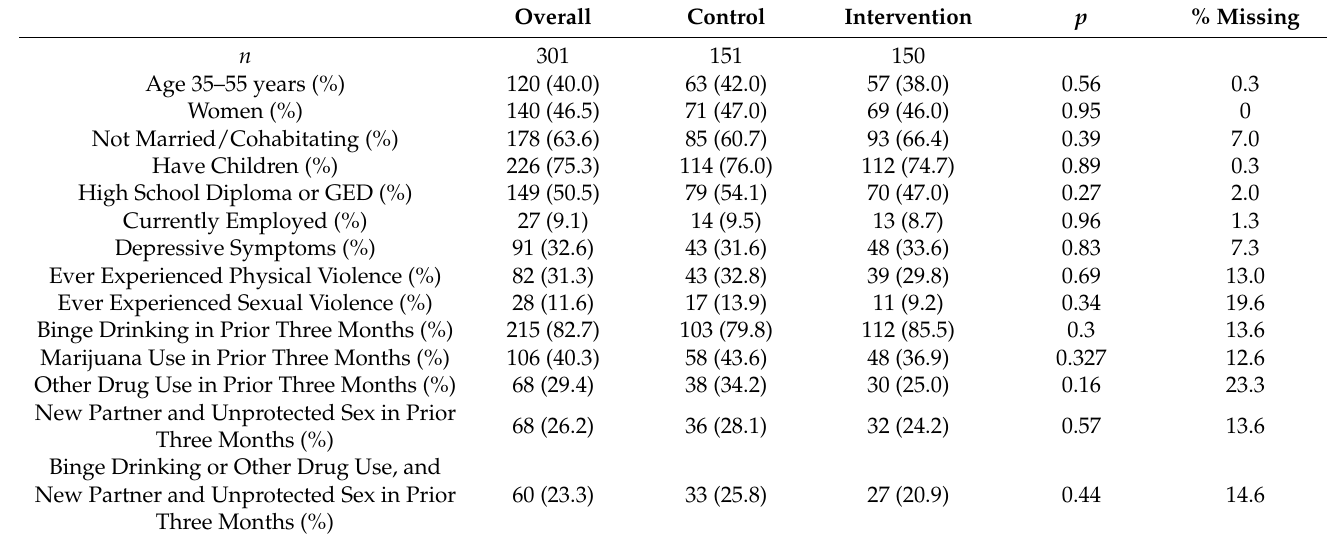
Table 1. Baseline characteristics of participants in a trial of an intervention to reduce sexually transmitted infection risks among Native Americans with binge substance use ( n =